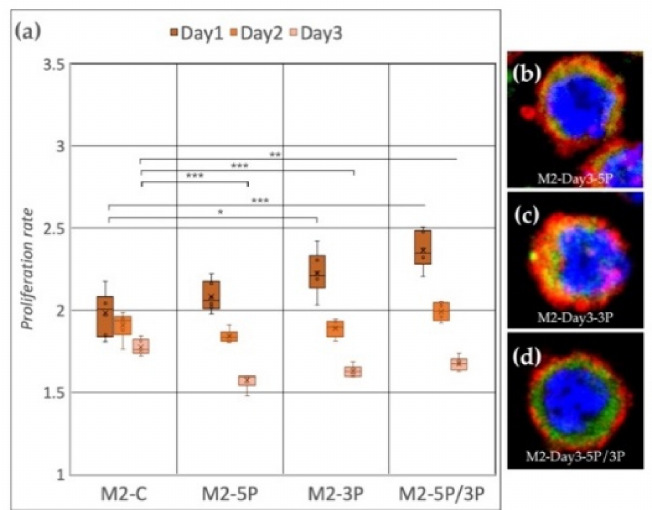
Figure 5. ( a ) Proliferation rate of M2 (ZZ genotype) PGC line on Day 1, Day 2 and Day 3. M2-C: non-inhibited, M2-5P: gga-miR-302b-5P inhibition, M2-3P: gga-miR-302b-3P inhibition, M2-5P/3P: gga-miR-302b-5P and gga-miR-302b-3P inhibition. ( b – d ) Immunostaining of M2 PGCs after three days of cultivation with different culture conditions. The immunostaining was achieved with SSEA-1 (red), CVH (green) and TO-PRO™-3 for nuclear staining (blue) ( p < 0.05 *, p < 0.01 **, p < 0.001 ***).